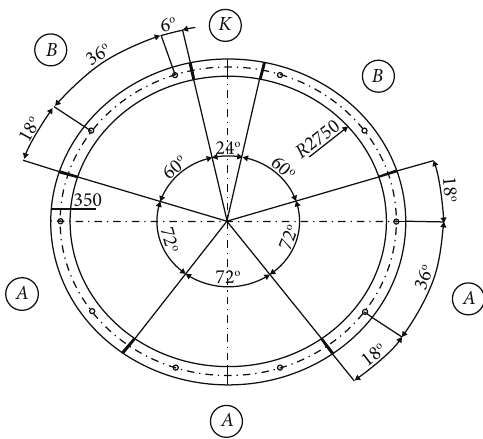
Figure 1: Cross section of the shield tunnel lining.